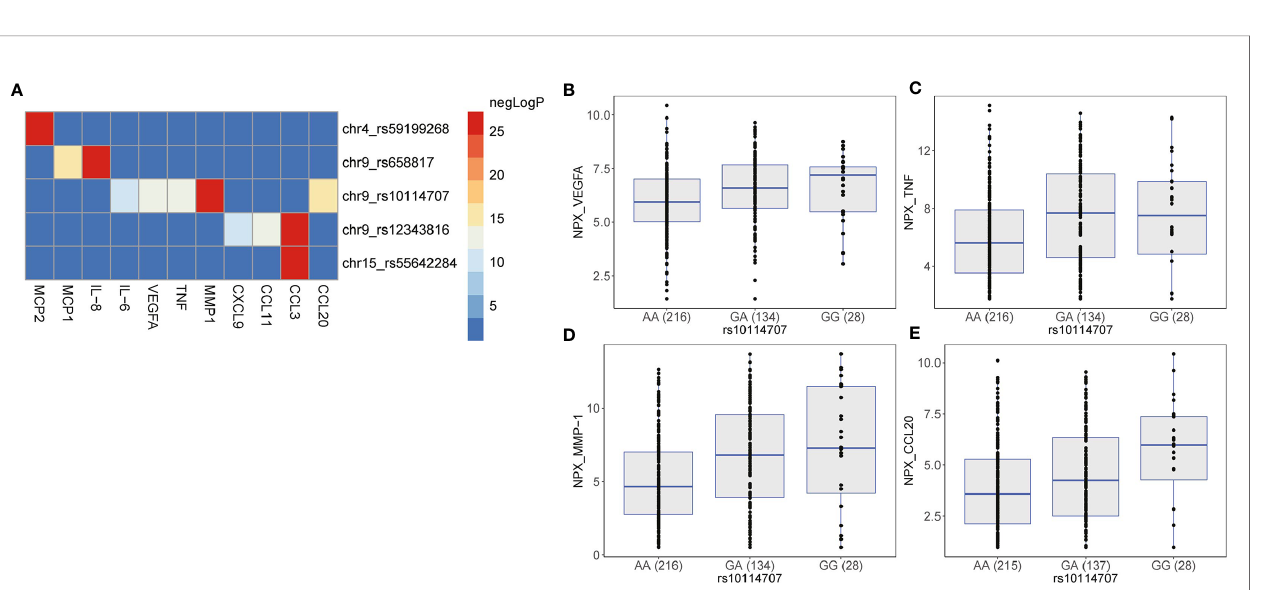
FIGURE 4 | Pleiotropy between genome-wide signi fi cant pQTLs and in fl ammatory proteins measured using the proximity extension assay (PEA) by Olink proteomics. Heatmap (A) shows the negative log 2 ( P ) of all possible associations of the genome-wide signi fi cant pQTLs and the measured in fl ammatory proteins that show the same allelic direction between 500FG and Lifelines Deep cohort at a P value of 0.0003, and P heterogeneity ≥ 0.05. Boxplots showing the expression levels (as NPX values) of (B) VEGFA, (C) TNF, (D) MMP-1, and (E) CCL20 when individuals from the 500FG and Lifelines Deep cohorts strati fi ed by genotype at the genome-wide locus,